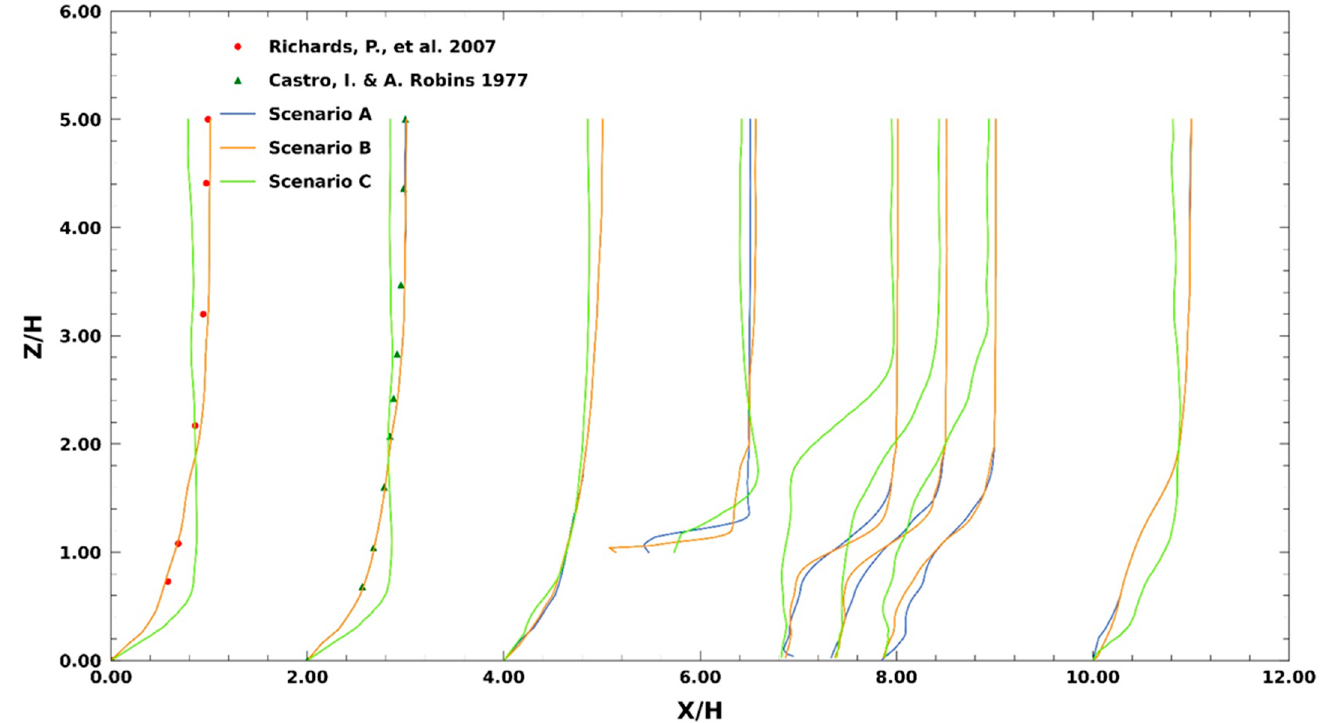
Figure 9. Normalized velocity profiles on the symmetry plane at positions X/H = 0, X/H = 2, X/H = 4, X/H = 5.5, X/H = 7, X/H = 7.5, X/H = 8 and X/H = 10 for Scenarios A–C [44,60].